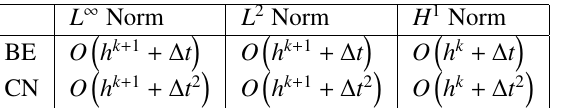
Table 1. Convergence Rates for IFE-MOL Algorithms L ∞ Norm L 2 Norm H 1 Norm